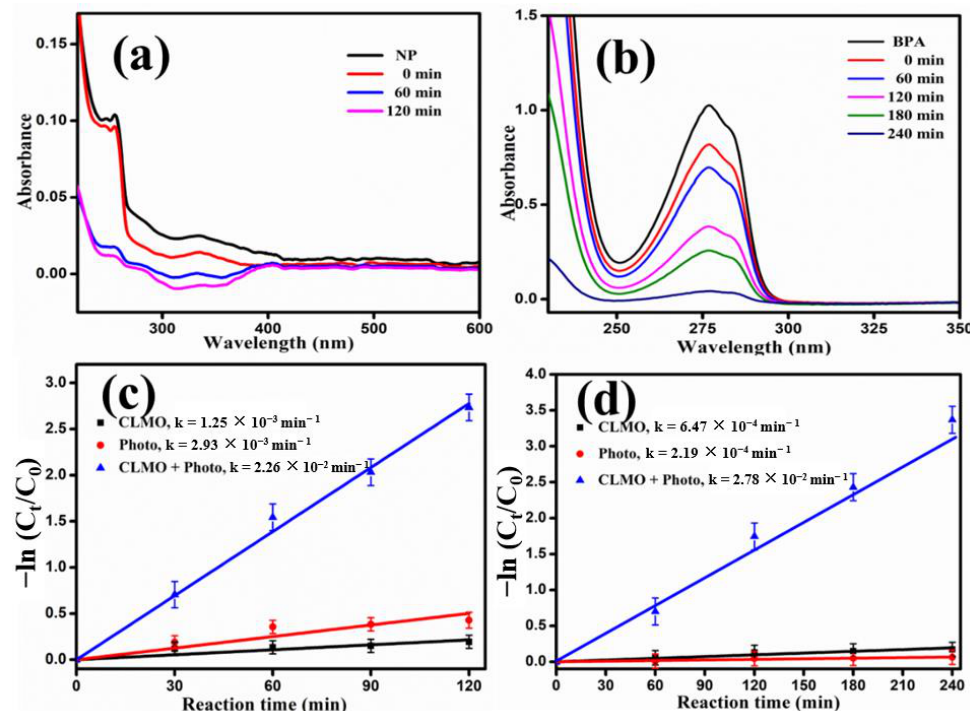
Figure 6. ( a , b ) Time-dependent UV-Visible spectrum of photocatalytic degradation of NP (Conc. 4 × 10 − 4 M) and BPA (Conc. 2 × 10 − 4 M) pollutants and ( c , d ) pseudo-first-order rate kinetics plot of NP (Conc. 4 × 10 − 4 M) and BPA (Conc. 2 × 10 − 4 M) pollutants, respectively, over CLMO catalyst (20 mg/100 mL) at pH 7. Table 1. The degradation efficacy and pseudo-first-order kinetics with an apparent rate constant of NP and BPA pollutants over CLMO